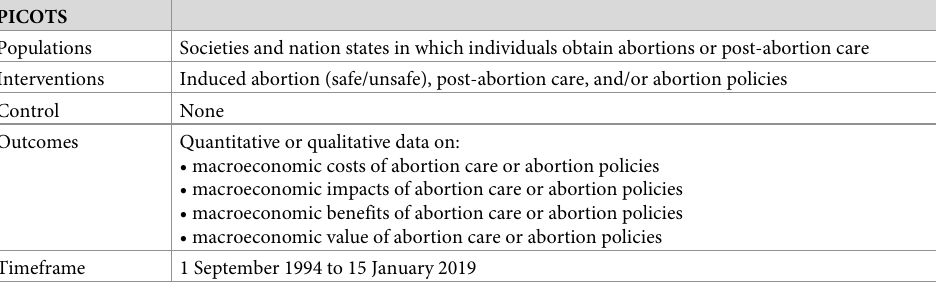
Table 1. PICOTS criteria used in the scoping review.